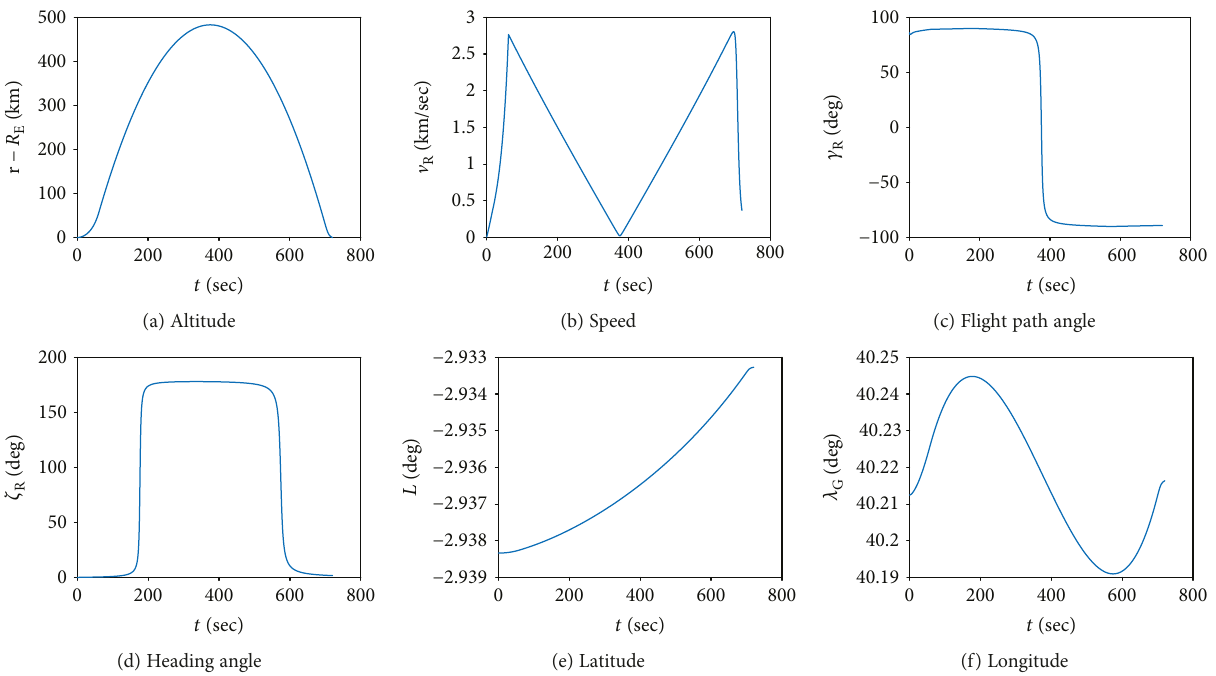
Figure 12: State variables for the con fi guration with l =7.29m and d =0.36m (near radial